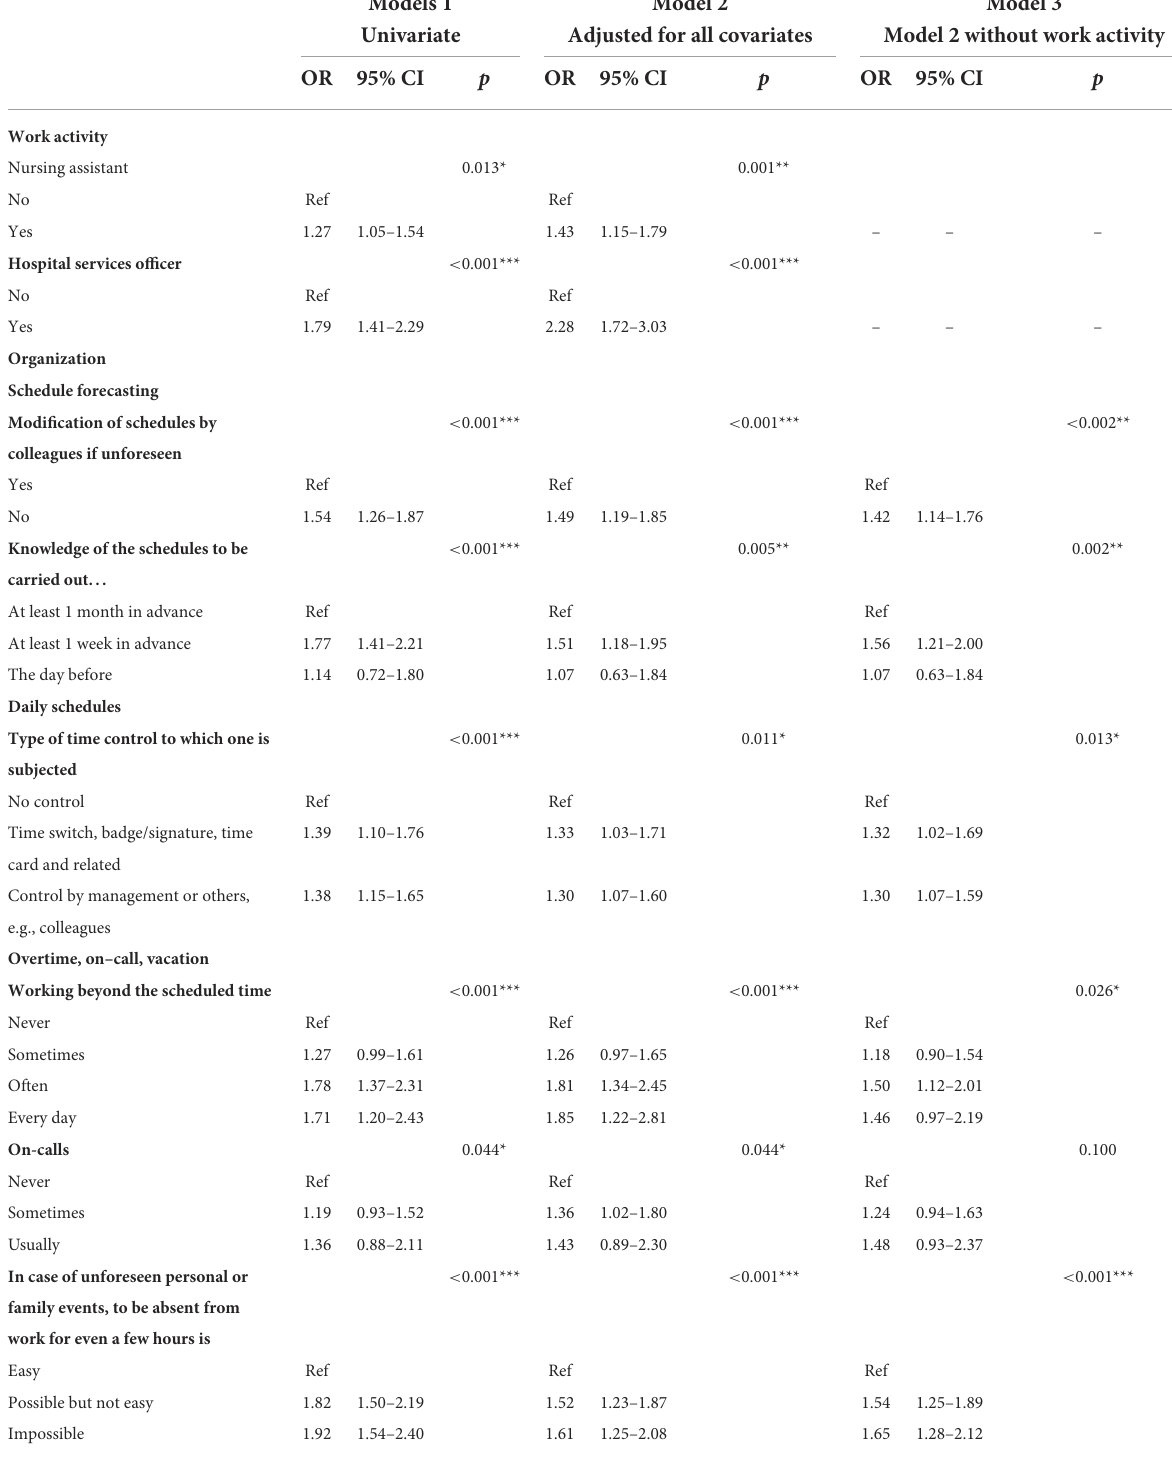
TABLE 4 Work activity and work organization characteristics a associated with belonging to care workers exposed to combinations of physical and psychosocial exposures with workplace injuries rates > 40 per 1,000 py ( n =